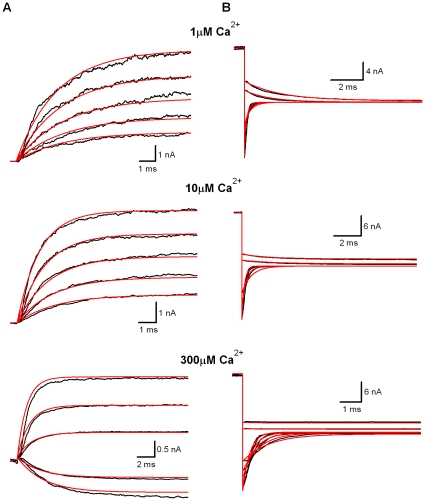
Fit a MWC model C5-O5 to the macroscopic currents of BK channels from Xenopus oocyte.(A) Activation traces of BK currents were recorded from an inside-out patch from a Xenopus oocyte injected with cRNA encoding mSlo1 α subunits. Channels were activated by voltage steps ranging from −200 to +200 mV with 10 mV increments from a holding potential of −180 mV with a cytosolic [Ca2+]i as indicated. The voltage protocol is not shown here. The red lines were coming from the globally fitting the model C5-O5 to BK currents by PSO-GSS algorithm. The channel count NC is 314 for 1 µM, 365 for 10 µM and 433 for 300 µM. The different Nc in the same patch is probably coming from the smaller single-channel conductance at the higher Ca2+, which will not change the channel kinetics. (B) Deactivation currents were obtained from the same patch as we described in (A). Currents were elicited by voltage steps ranging from −200 to +180 mV with 10 mV increments from a 20 ms-prepulse of +180 mV with a cytosolic [Ca2+]i as indicated. The red lines are fits by a PSO-GSS algorithm. The channel count NC is 301 for 1 µM, 354 for 10 µM and 387 for 300 µM. The score σ2 is 41.60. All the capacitive currents of 0.15 ms were pre-substituted with straight lines before run and not counted during run. The dash line is zero current.